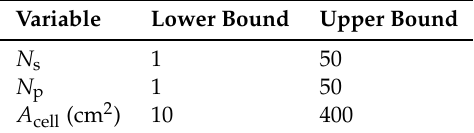
Table 6. Bounds of the design variables [23].